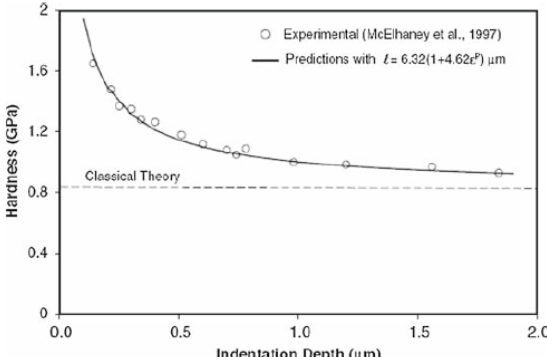
Figure 21. Indentation size effect (ISE) ( a ) for geometrically self-similar indenters such as a conical or pyramidal tip ( b ) [46].